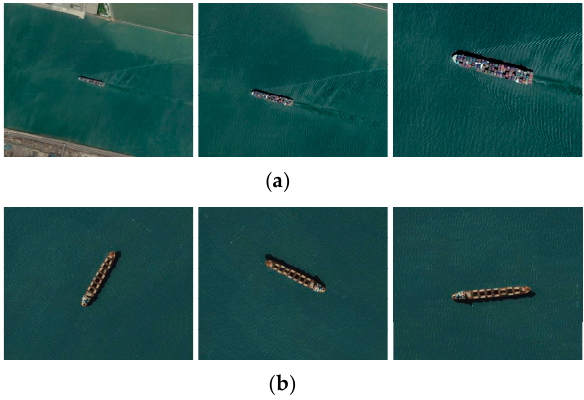
Figure 1. Two typical challenges for ship detection in optical remote sensing (ORS) images. ( a ) Three different scales. The scale change increases the difficulty of the candidate region extraction. ( b ) Three different rotations. The rotation change increases the difficulty of feature extraction.